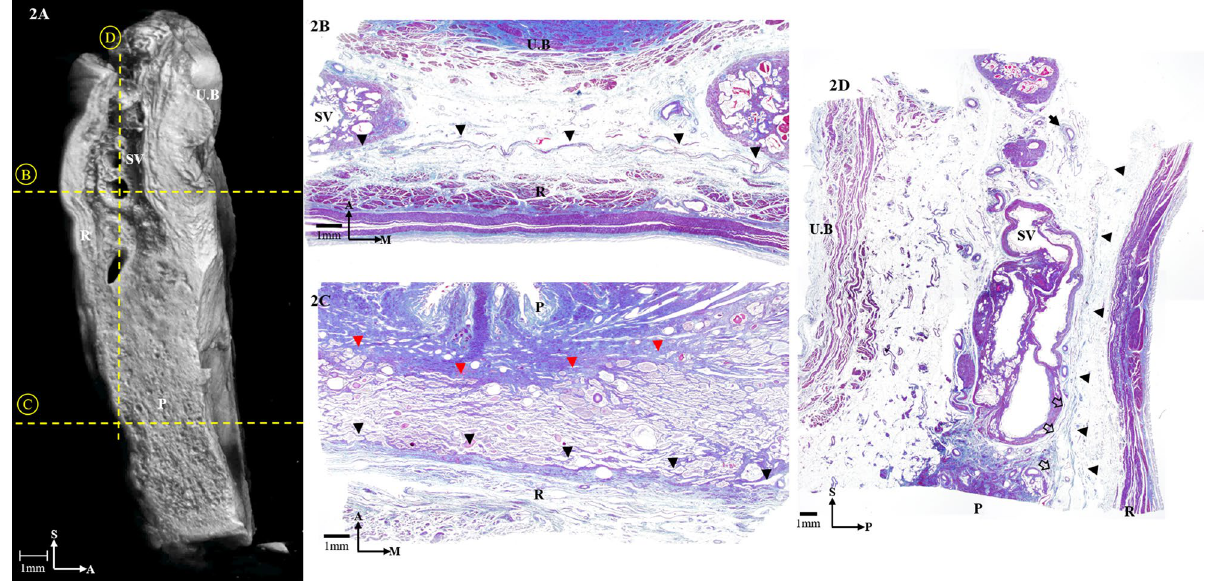
Figure 2. ( A ) Three-dimensional anatomy of the hemi-pelvis from a sagittal section reconstructed from micro- computed tomography. ( B ) Masson trichrome-stained section at the level of the seminal vesicles. Horizontal sections of the Denonvilliers’ fascia (DVF) are indicated by the black arrowheads. ( C ) Masson trichrome-stained section at the level of the prostate. Horizontal sections of the DVF are indicated by the black arrowheads and of the prostatic capsule is indicated by the red arrowheads. ( D ) Masson trichrome-stained section of the specimen. The black arrowheads indicate sagittal sections of the DVF, and the black arrow indicates the neurovascular bundle. The distal seminar part of the DVF merging with the prostatic capsule is indicated by the white arrows. UB, urinary bladder; SV, seminal vesicle; P, prostate; R, rectum; S, sagittal; M, medial; A, anterior; P, posterior.